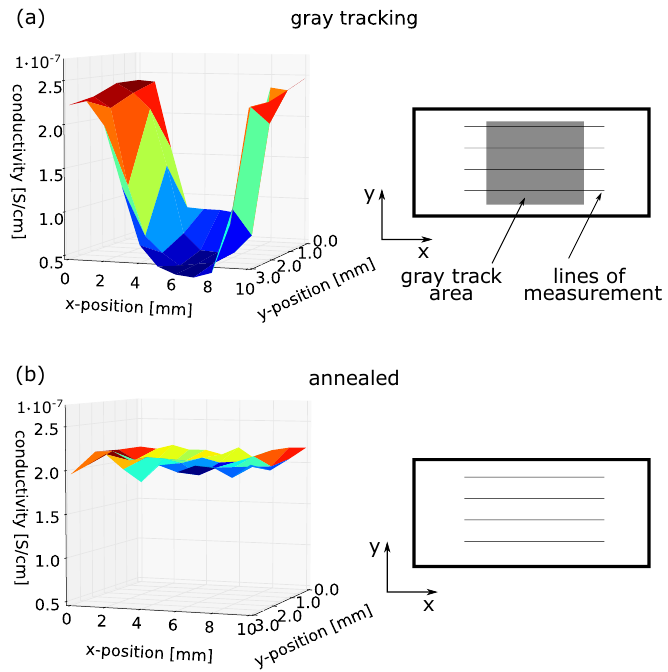
Figure 5. Comparison of the ionic conductivity between ( a ) gray-tracked and ( b ) annealed